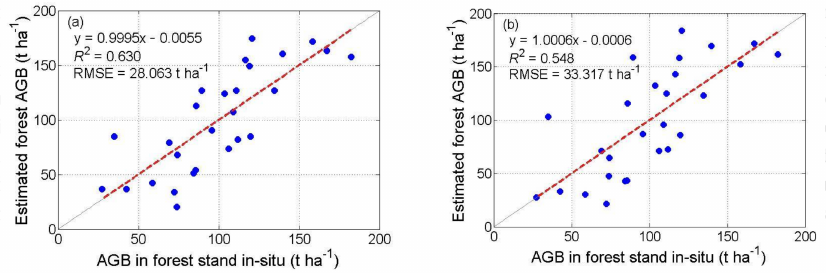
Figure 8. Forest AGB estimation results using ( a ) H ac and ( b ) TomoH in 314 deg. flight direction.